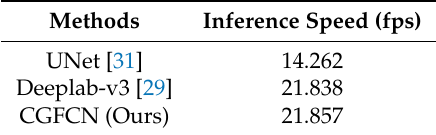
Table 3. Average inference speed (frames per second) of different models.